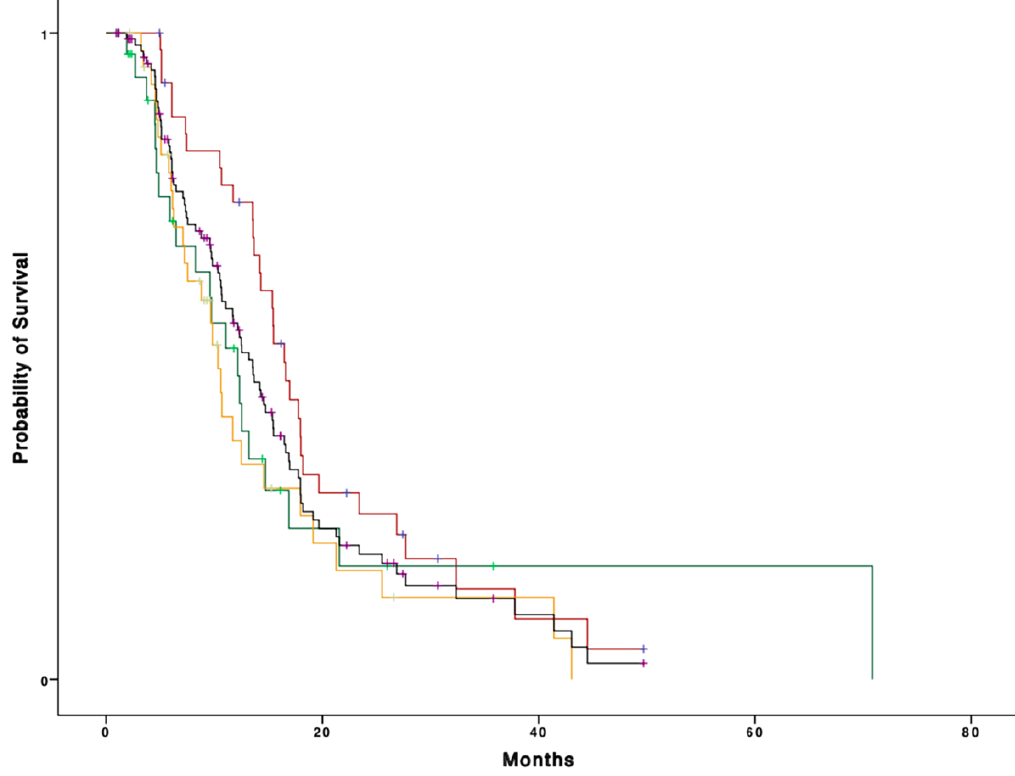
Figure 1. Kaplan – Meier curve representing overall survival (OS) according to CGA categories (fit patients: red line; vulnerable patients: green line; frail patients: orange line; whole population: black line).